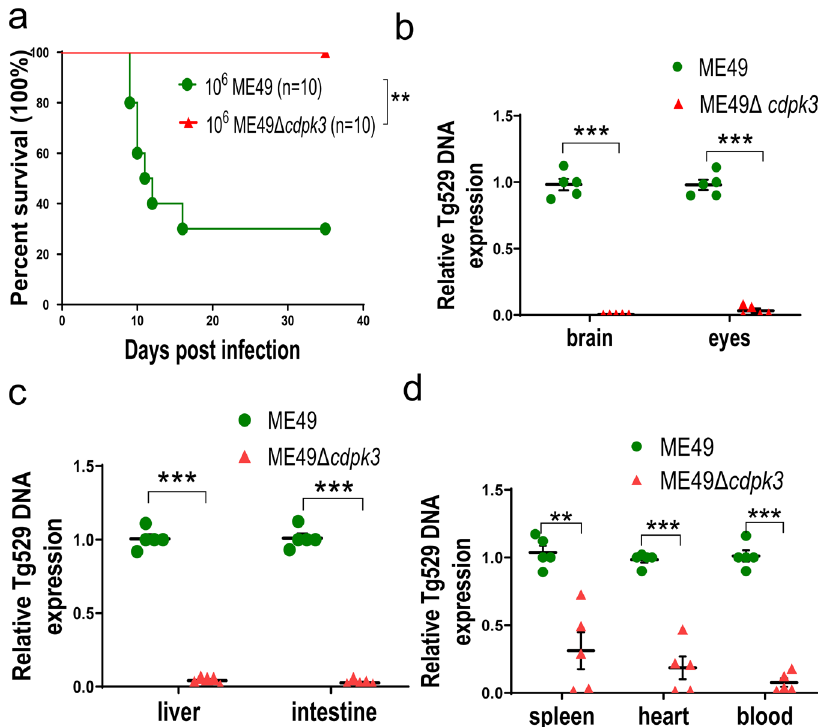
Fig. 2 The mutant of CDPK3 in ME49 strain severely attenuated the virulence in mice. Female BALB/c mice were infected with 10 6 wild-type or ME49 Δ cdpk3 parasites by intraperitoneal injection. a Survival rate of mice was monitored for 35days ( n = 10 per group). ** p < 0.01. Gehan – Breslow – Wilcoxon tests. b – d Seven-days post-infection, parasite burdens in brain, eyes, liver, ileum, spleen, heart, and blood were estimated by quantitative PCR ( n = 5 each group). All statistical analyses were performed by using unpaired t test. Bars = mean ± standard error of the mean (SEM). Statistical differences are represented by *** p < 0.001, ** p <